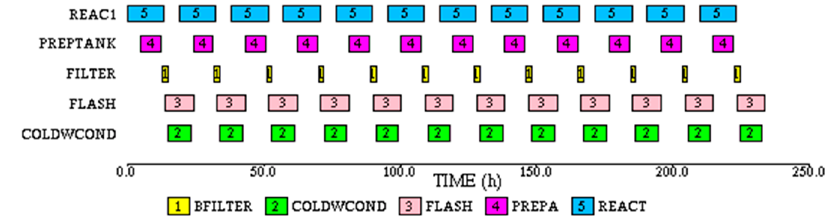
Figure 15. Gantt chart with 19.06 h elapsed time between reactor batches.